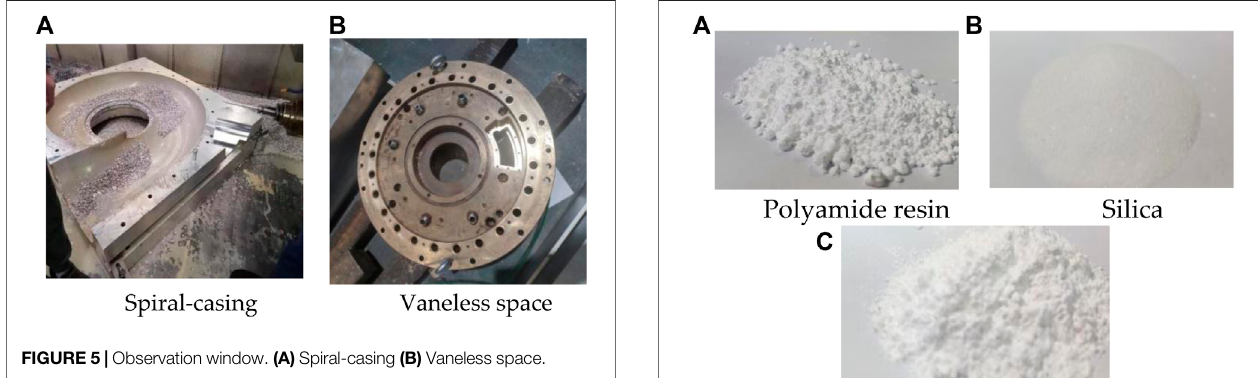
FIGURE 5 | Observation window. (A) Spiral-casing (B) Vaneless space.